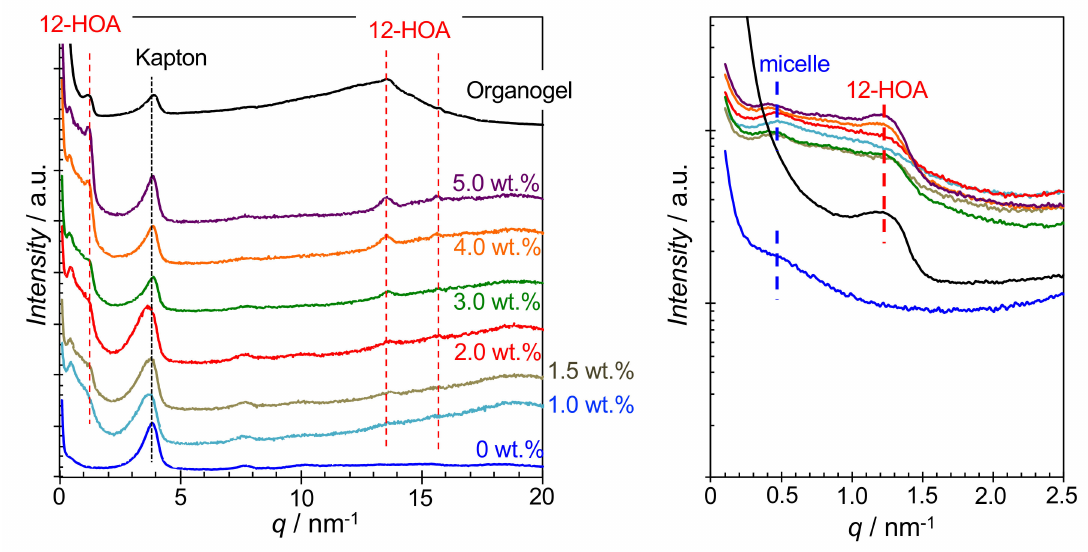
Figure 2. Small- and wide-angle X-ray scattering (SWAXS) spectra of the hydrogels in the hexadecyltrimethylammonium bromide (CTAB) system at di ff erent 12-hydroxyoctadecanoic acid concentrations ( C 12-HOA = 1.0–5.0 wt.%), non-gelled CTAB micellar solutions ( C 12-HOA = 0 wt.%), and organogel ( C 12-HOA = 3.0 wt.%, in n-decane) at 25 ◦ C. The small angle peaks at q ~4 nm − 1 are from Kapton